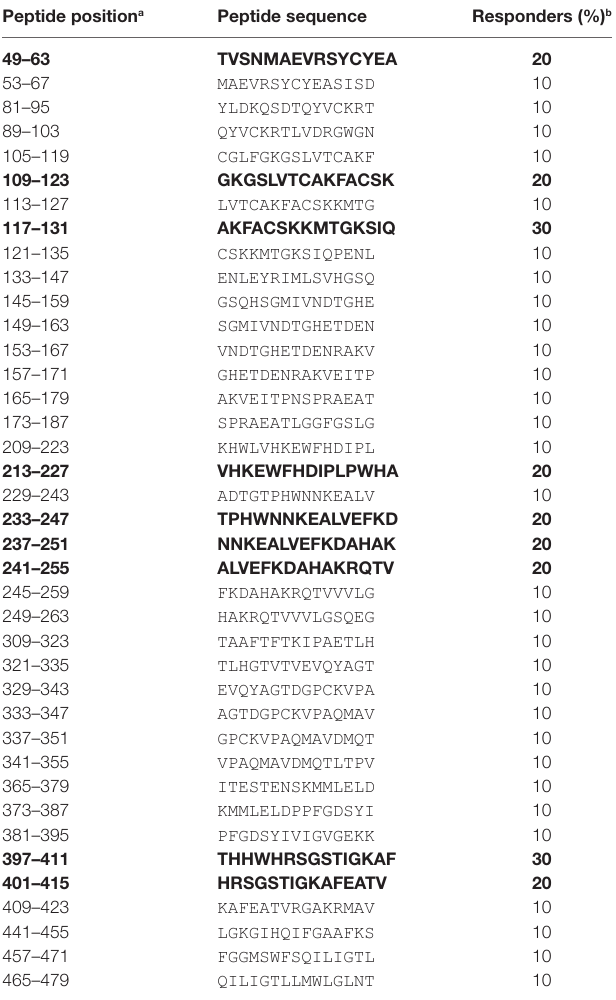
TaBle 3 | Identified CD4 T cell epitopes from Zika virus E protein. Peptide position a Peptide sequence